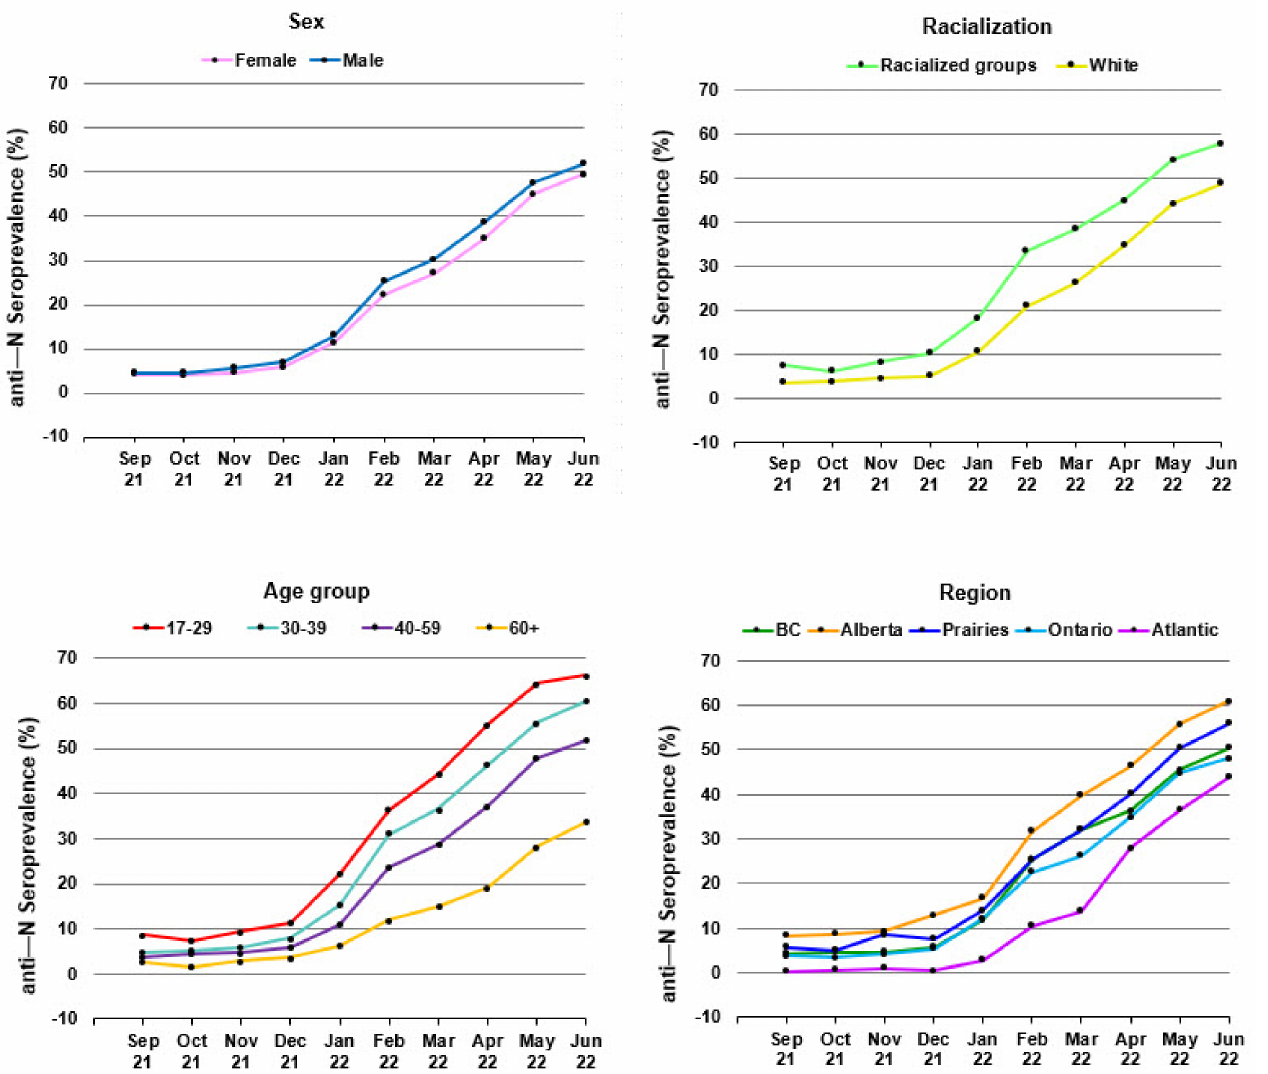
Figure 1. Anti—N seroprevalence from September 2021 - June 2022 by sex, racialization, age group, and